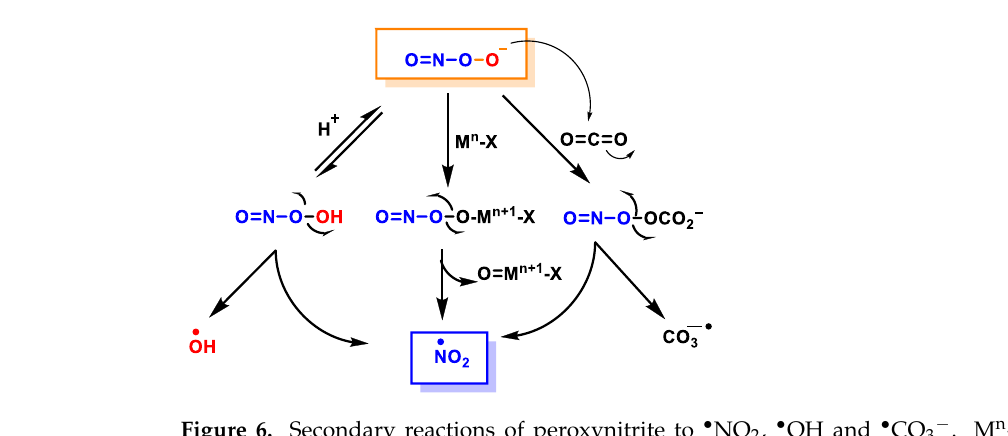
Figure 6. Secondary reactions of peroxynitrite to • NO 2 , • OH and • CO 3 − . M n -X represents a metalloprotein, in which the co-ordinate metal moves up one valence to M n+1 -X, as is the case for the superoxide dismutase SOD1.